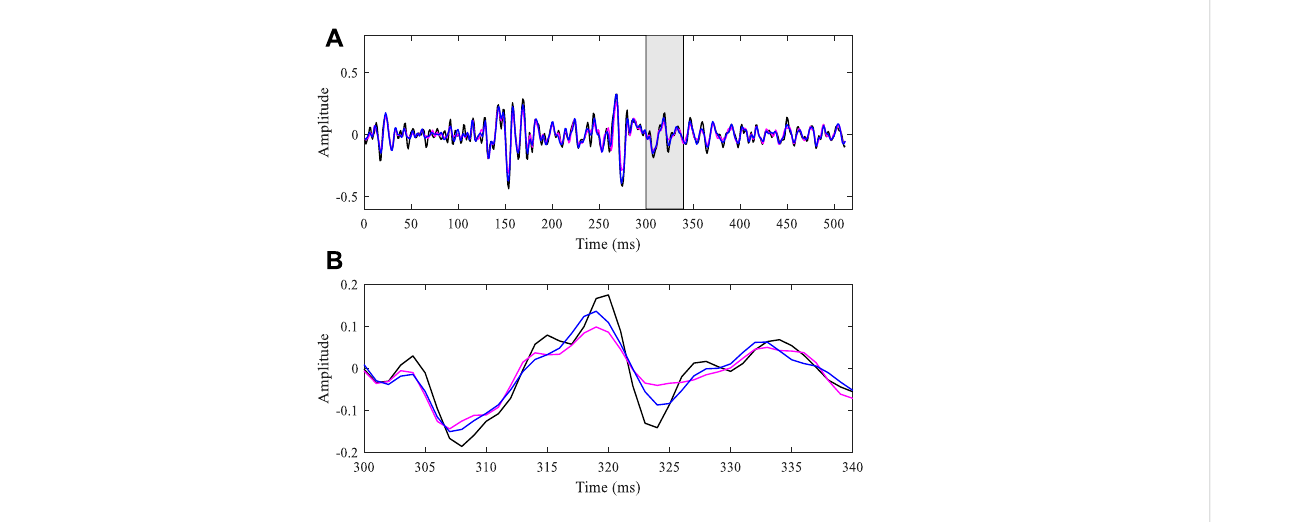
FIGURE 7 (A) Comparison of a missing single-trace amplitude interpolated with FISTA and SFISTA methods; (B) zoomed traces from the transparent gray window of (A)